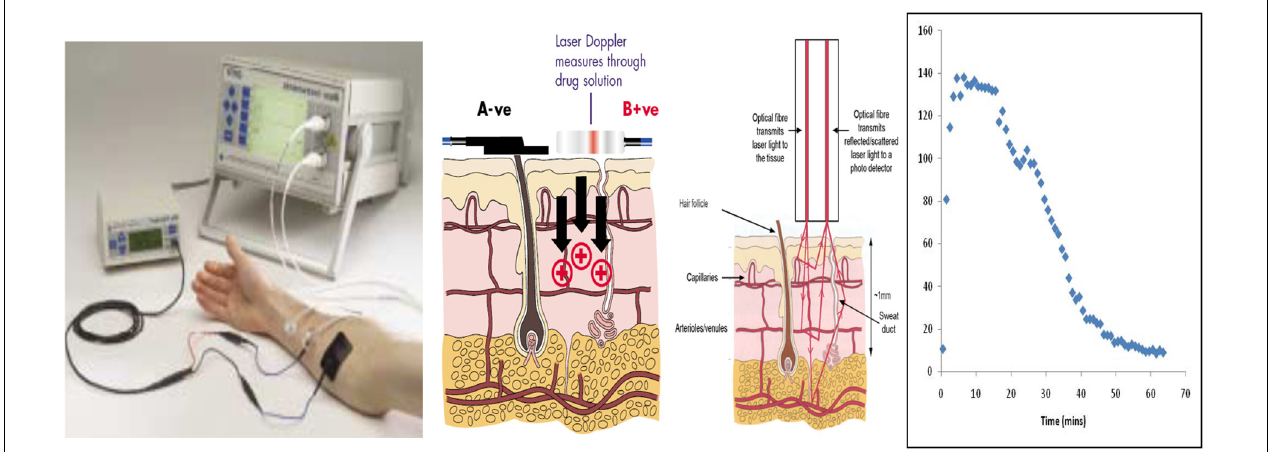
FIGURE 1 | Illustration of the HILD set up. Left most panel – shows the instrumentation set up. Middle left panel – shows the delivery of the drug through the positive terminal. Middle right panel – shows the transmission of the laser into the tissue and the return of the scattered light which is detected by the photo detector. Right panel – shows an example histamine (flux) profile over time. Images in the first two panels provided with permission and courtesy of Moor Instruments.